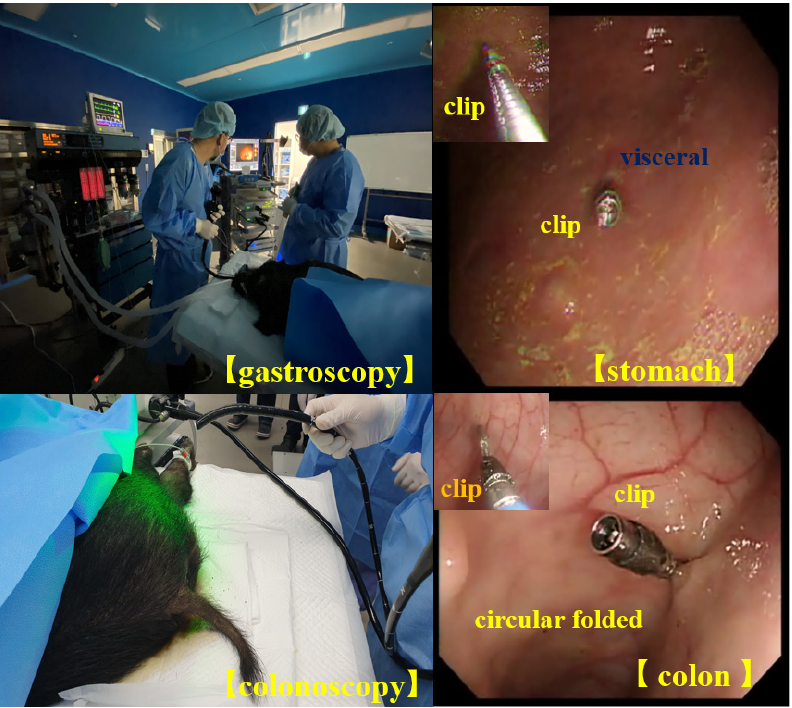
Figure 12. Clips installed in the mucosa of the colon and stomach using guided gastroscopy and colonoscopy. After installing the clips using an endoscope, we tested the detection performance of the sensor during laparoscopic surgery, as shown in Figure 13a. The detector is inserted into the abdominal cavity using a trocar, and the detector begins to detect the clips in the visceral cavity, as shown in Figure 13b. When the clips present in the stomach (visceral cavity) and colon (circular folds) are detected, the detector produces an amplitude of 3.20 V (at 1.59 kHz), as shown in Figure 13c, and an alarm is generated, which is audible through the speaker. When the detector encounters the clip, the detector is coupled to the clip; therefore, the detection time is 1.11 and 1.18 s for the clip present in the stomach and colon, respectively (investigation time is 2.17 and 3.41 s, respectively). Herein, 1.08 and 1.16 s are the reaction speeds when the detector is coupled with the clip for the stomach and colon, respectively, and the time required to locate the clip in the stomach and colon is 2.17 and 3.41 s, respectively. Additionally, no time delays occur, and the response time for detecting the tumor is short.